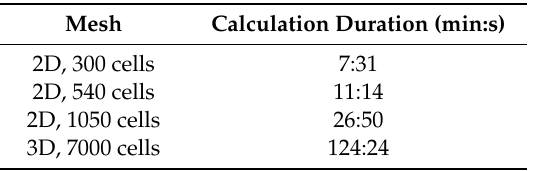
Table 3. Mesh cell number and calculation time.